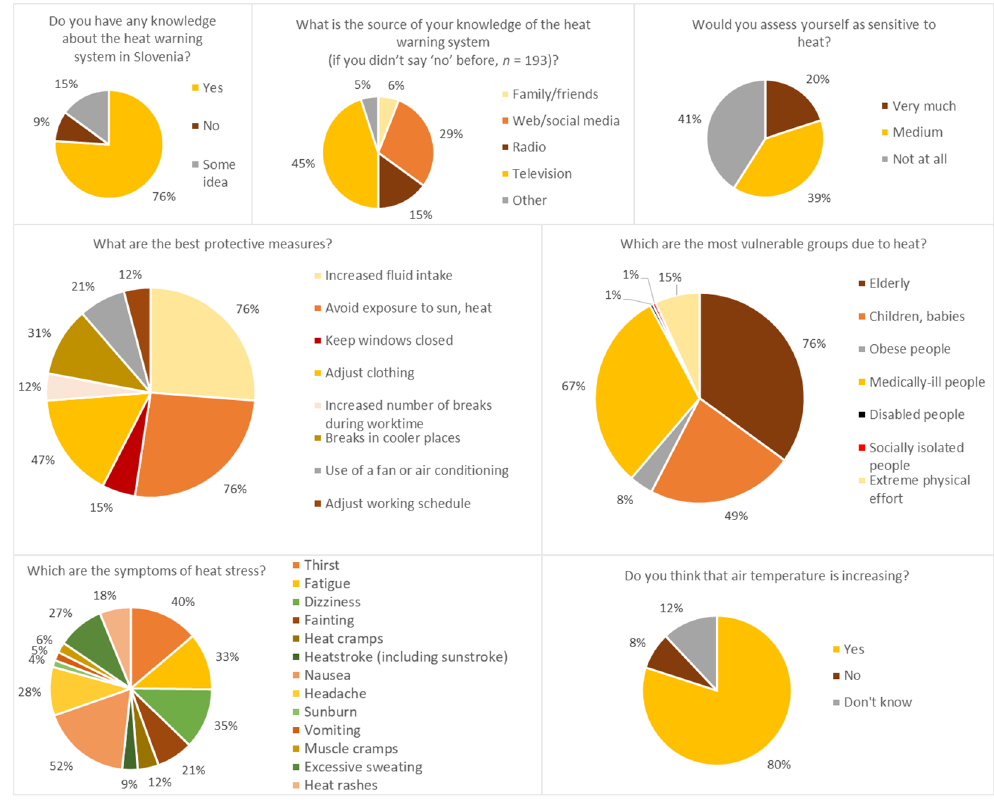
Figure 5. Response of the general public ( n = 213) to questions about heat warnings and heat stress, collected in Ljubljana, Slovenia in the summer of 2017.